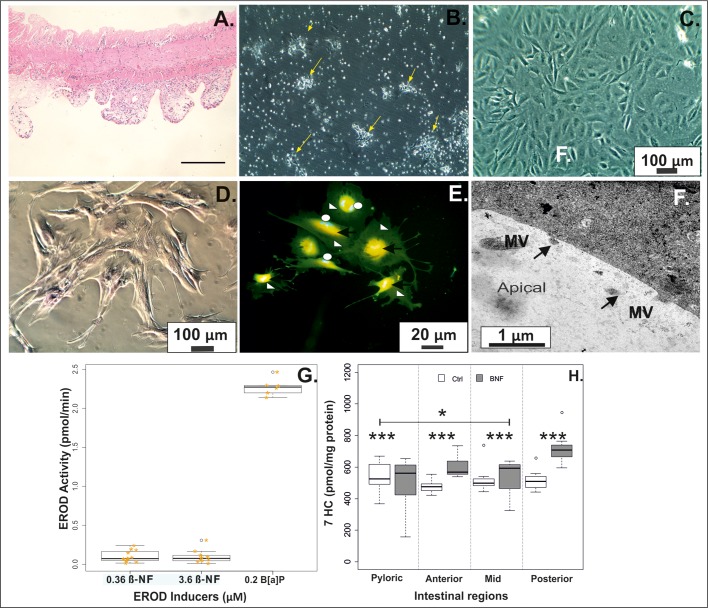
Morphological and metabolic characterisation of cultures of primary isolated intestine cells. (A) Tissue was collected post cellular isolation (Step 4: Fig. 2), paraffin embedded and stained with Haematoxylin and Eosin (H&E). The uppermost enterocyte layer is clearly absent, with minimal perturbation of the cellular supporting architecture. This was confirmed through (B) epithelial clusters 48 h post isolation and (C) predominance of epithelial morphology following 9 days in culture (pyloric). (D) Staining for mucosubstances demonstrates a dominance of neutral mucosubstances in the mid intestine (9 days), although this does vary between regions. (E) Immunofluorescence microscopy of pyloric cells (7 days), fixed and stained with antibodies specific to ZO-1 (red), E-cadherin (green; open triangle) and DAPI (blue; Open circles on boxplots represent data outside the interquartile range of the data) for nucleus stain. ZO-1 and E-cadherin are known as cell adhesion associated substances and when co-expressed (black arrows) may play an important role in cellular differentiation. Proteins are clearly co-expressed in cultures as can also be seen in intestinal tissue (Fig. S2). (F) TEM revealed polarised cultures with micro-villi (MV) projections (arrows) after 9 days in culture (posterior intestine), a trend observed throughout all cultures. In addition to polarised MV, cultures also maintained tight junctions, endoplasmic reticulum and lysosomes. (G) Activation of EROD activities in pyloric cultures using known inducers, with significant differences only observed with the use of B(a)P (n=10, P<0.001) relative to controls. This trend was uniformly observed for all intestinal cultures. Gold stars represent jittered individual data points. (H) Activation of ECOD activity was measured using a 24 h β-NF exposure. Significant differences were found between control and exposure in all cultures (P<0.001), in addition to significant differences observed between the pyloric and mid response (P<0.05). Box and whisker plots (G,H) display the distribution of data based on the first and third quartile and median of the data, with open circles representing data outside the interquartile range.